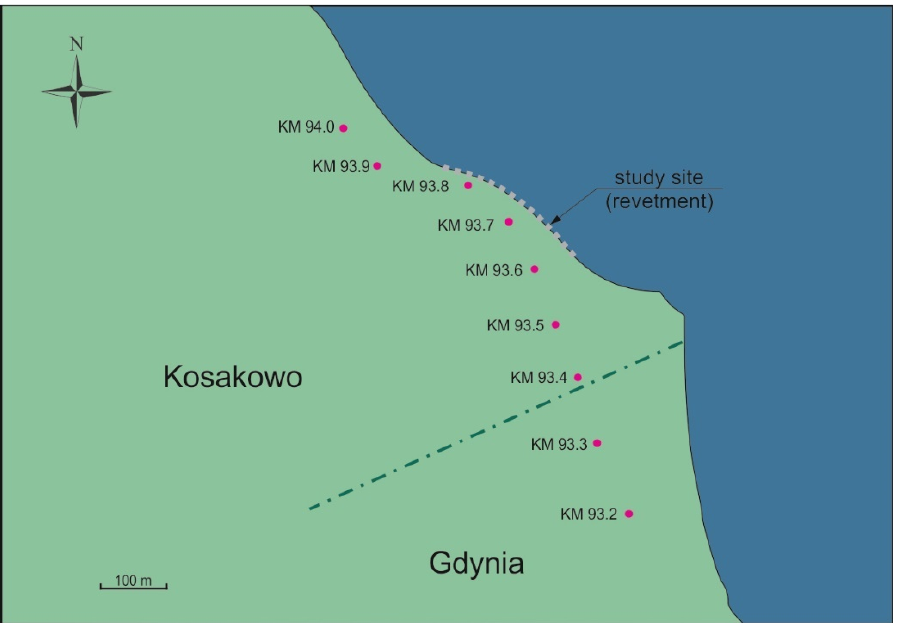
Figure 3. The analysed section of coastline.